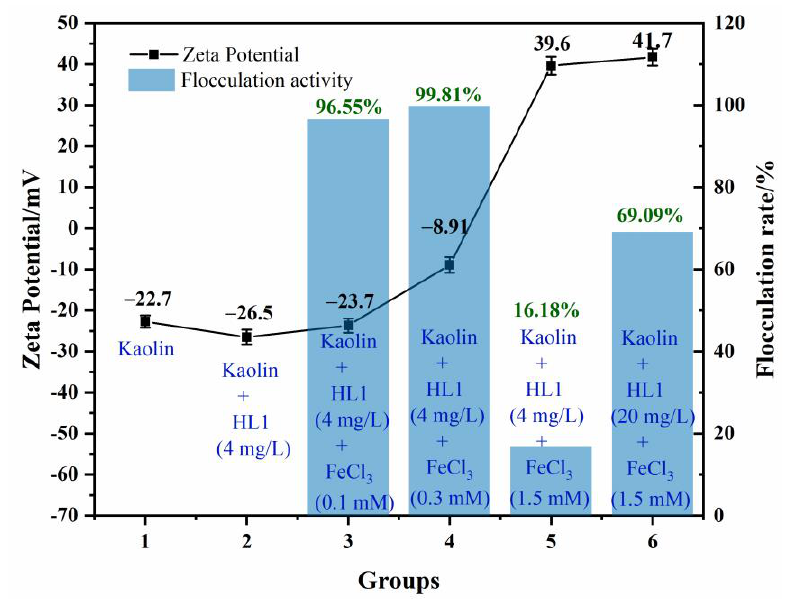
Figure 2. Zeta potential and flocculation activity of kaolin mixture system.